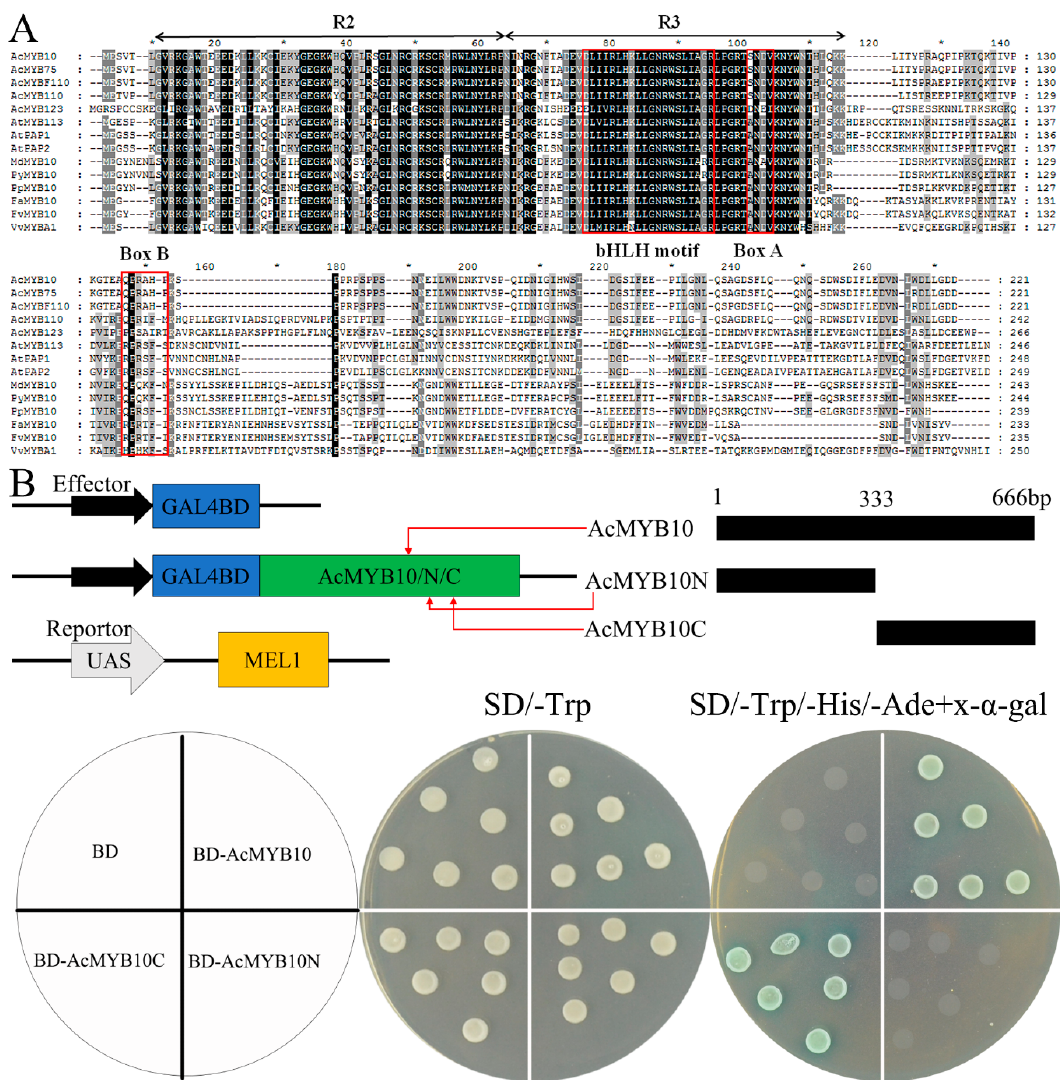
Figure 5. Analyses of the AcMYB10 activation domain. ( A ) Amino acid sequence alignment of Acc00493 ( AcMYB10 ) and other plant anthocyanin-promoting MYBs. Totally conserved residue is highlighted in black and partial conserved is highlighted in gray. R2 and R3 MYB motifs are indicated by arrows. The bHLH motif indicates the residues needed for the interaction with the bHLH partner; box A and box B are well-conserved in anthocyanin-promoting MYBs. The asterisks indicate the number of amino acid. The GenBank accession numbers are: AcMYB75 (APZ74276.1), AcMYBF110 (AYJ72555.1), AcMYB110 (AHY00342.1), AcMYB123 (QAT77713.1), AtMYB113 (NP_176811.1), AtPAP1 (Q9FE25.1), AtPAP2 (Q9ZTC3.1), MdMYB10 (ABB84753.1), PyMYB10 (ADN26574.1), PpMYB10 (ADK73605.1), FaMYB10 (ABX79947.1), FvMYB10 (ABX79948.1), VvMYBA1 (AGH68552.1). ( B ) Transcriptional activity assay of AcMYB10 . Schematic of the full length and three truncated fragments (AcMYB10N and AcMYB10C) of AcMYB10 used for constructing vectors. E ff ectors and reporter used for transcriptional activation activity assay. Growth of yeast cells (strain AH109 ) transformed with each of the three vectors or pGBKT7 empty vector (used as a negative control) on SD / -Trp or SD / -Trp / -His / -Ade, with the addition of X- α -gal. The layout of the e ff ectors is shown in the pie chart on the left. The AcMYB10 protein contained a highly conserved N-terminal R2R3 repeat of a DNA-binding 2.7. Gene Functional Study by Overexpression of AcMYB10 in A. chinensis cv. Hongyang and Using the domain with a bHLH motif which was functionally important for the interaction between MYB and VIGS (Virus-Induced Gene Silencing) System in A. chinensis cv. Hongshi No. 2 R / B-like bHLH proteins [37] (Figure 5A). To determine the transcriptional activation activity of AcMYB10